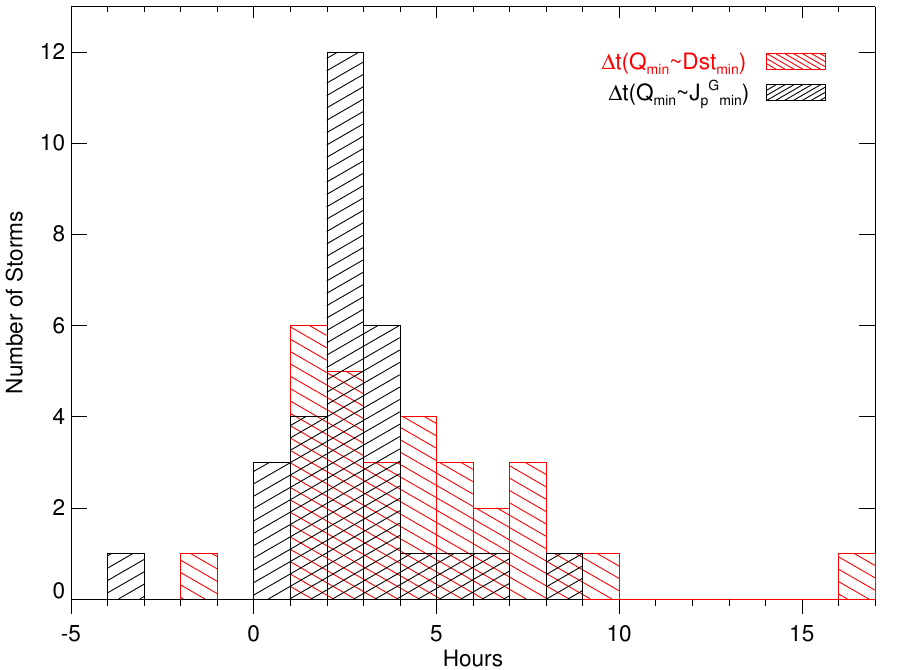
Figure 8. The distribution of delay times between Q minimum and Dst minimum (red), denoted as ∆ t ( Q min ∼ Dst min ) , and delay times between Q minimum and J G p minimum (black), denoted as ∆ t ( Q ∼ J G ) min p min